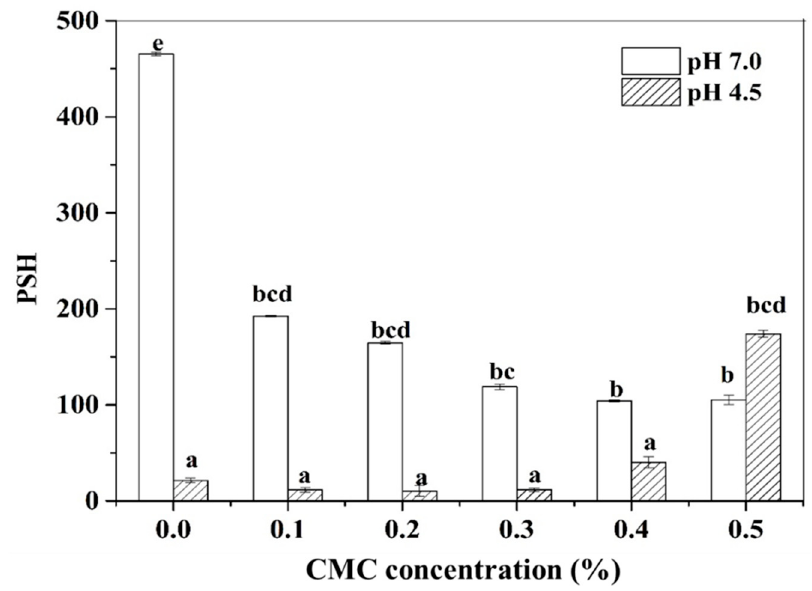
Figure 5. Effects of CMC concentration on the protein surface hydrophobicity (PSH) of PPI (3.0%) at pH 7.0 and pH 4.5 in the aqueous systems. Different letters indicate a statistically significant difference at the same pH ( p < 0.05).